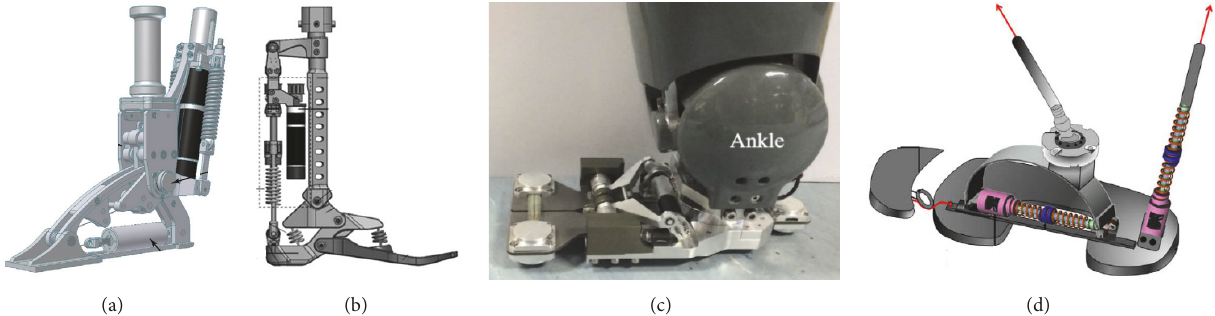
Figure 12: Developed foot prostheses. (a) The AMP-Foot 2.0 [26, 27]. (b) Virtual prototyping of a semiactive transfemoral prosthetic leg [28]. (c) Variable compliant humanoid foot [29]. (d) Bioinspired tunable stiffness robotic foot [30].